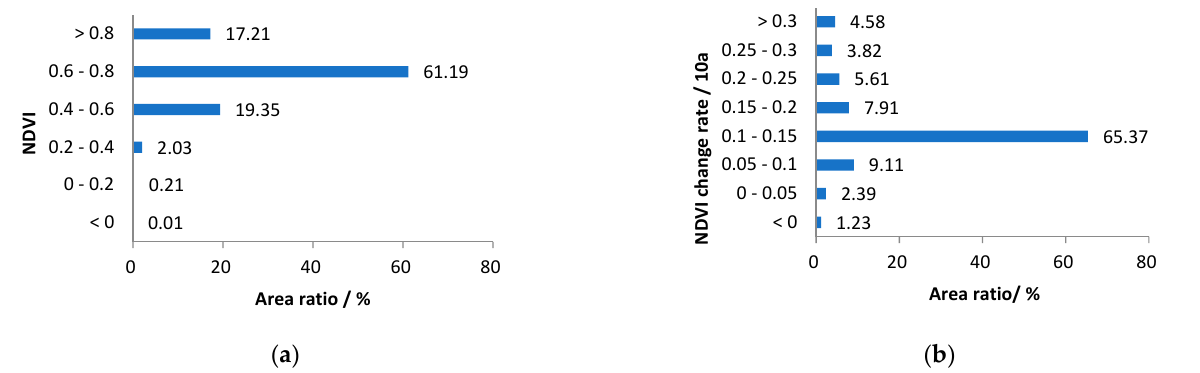
Figure 6. The area ratio of NDVI ( a ) and NDVI changing trend ( b ) in Qin Mountains during 1987–2019.